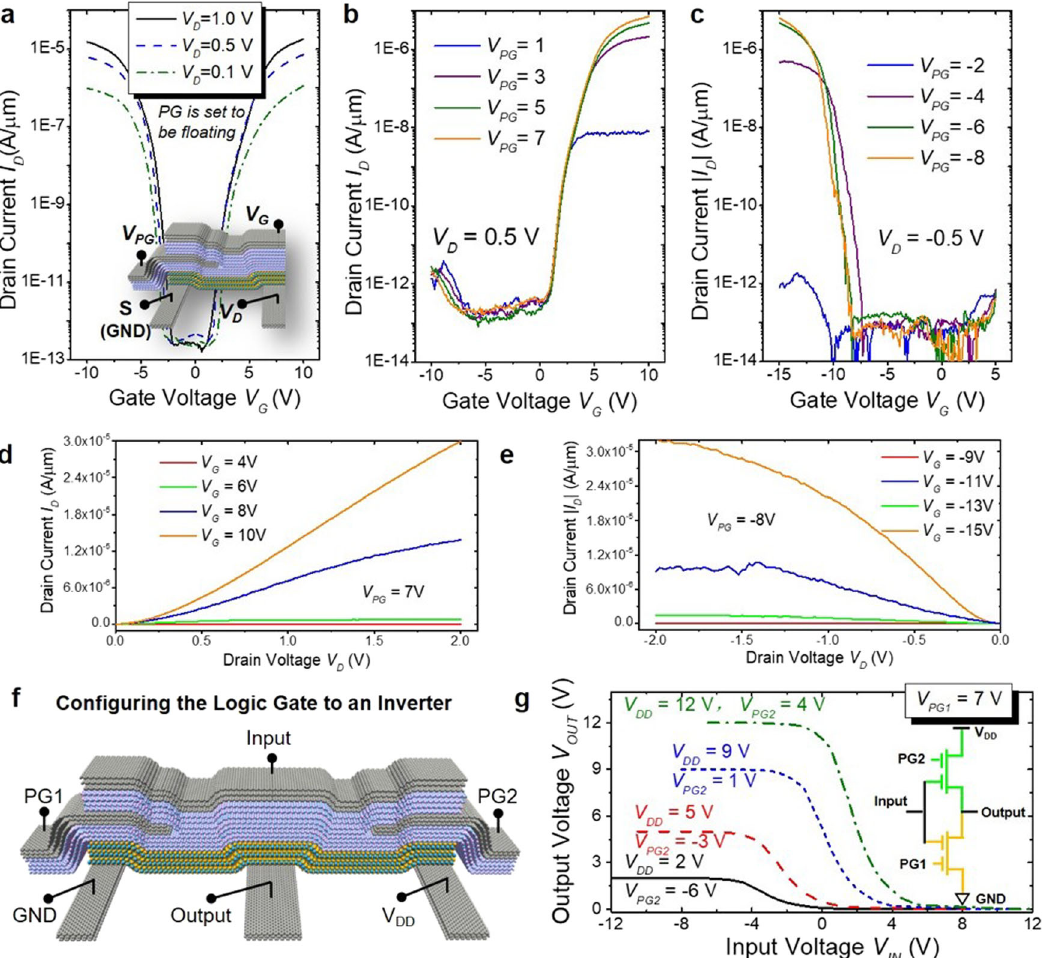
Fig. 3 Electrical characterization of fabricated recon fi gurable logic gate in vdW strata. a Measured I D – V G curves in conventional FET mode, as illustrated in the inset. PG is set to be fl oating. b Measured I D – V G curves in n - mode and c p -mode from the same device (shown in the inset in a ). d Measured I D – V D curves in n - mode and e p -mode from the same device (shown in the inset in a ). f Biasing setup of the fabricated gate as an inverter. g Measured voltage transfer